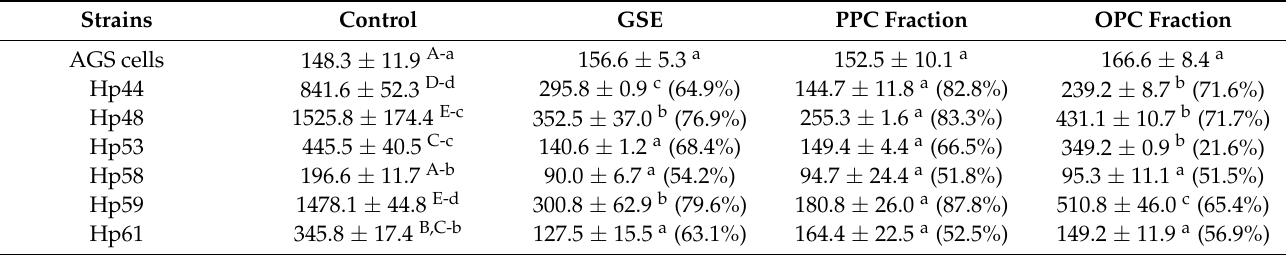
A,B,C,D The same uppercase letter within the control column represents no significant difference ( p > 0.05) between the strains by ANOVA post hoc LSD Tukey test. a,b,c,d The same lowercase letter within the same row represents no significant difference ( p > 0.05) between treatments (GSE or its fractions) for each strain by ANOVA post hoc LSD Tukey test. Percentages shown in parentheses indicate the reduction in IL-8 production compared to the infected and untreated